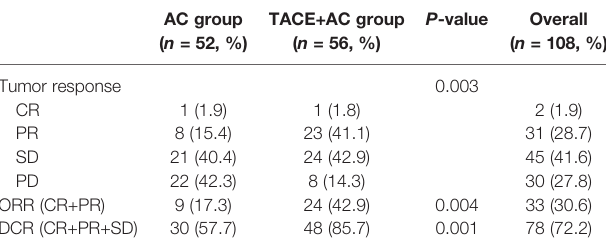
TABLE 3 | Summary of tumor response based on mRECIST